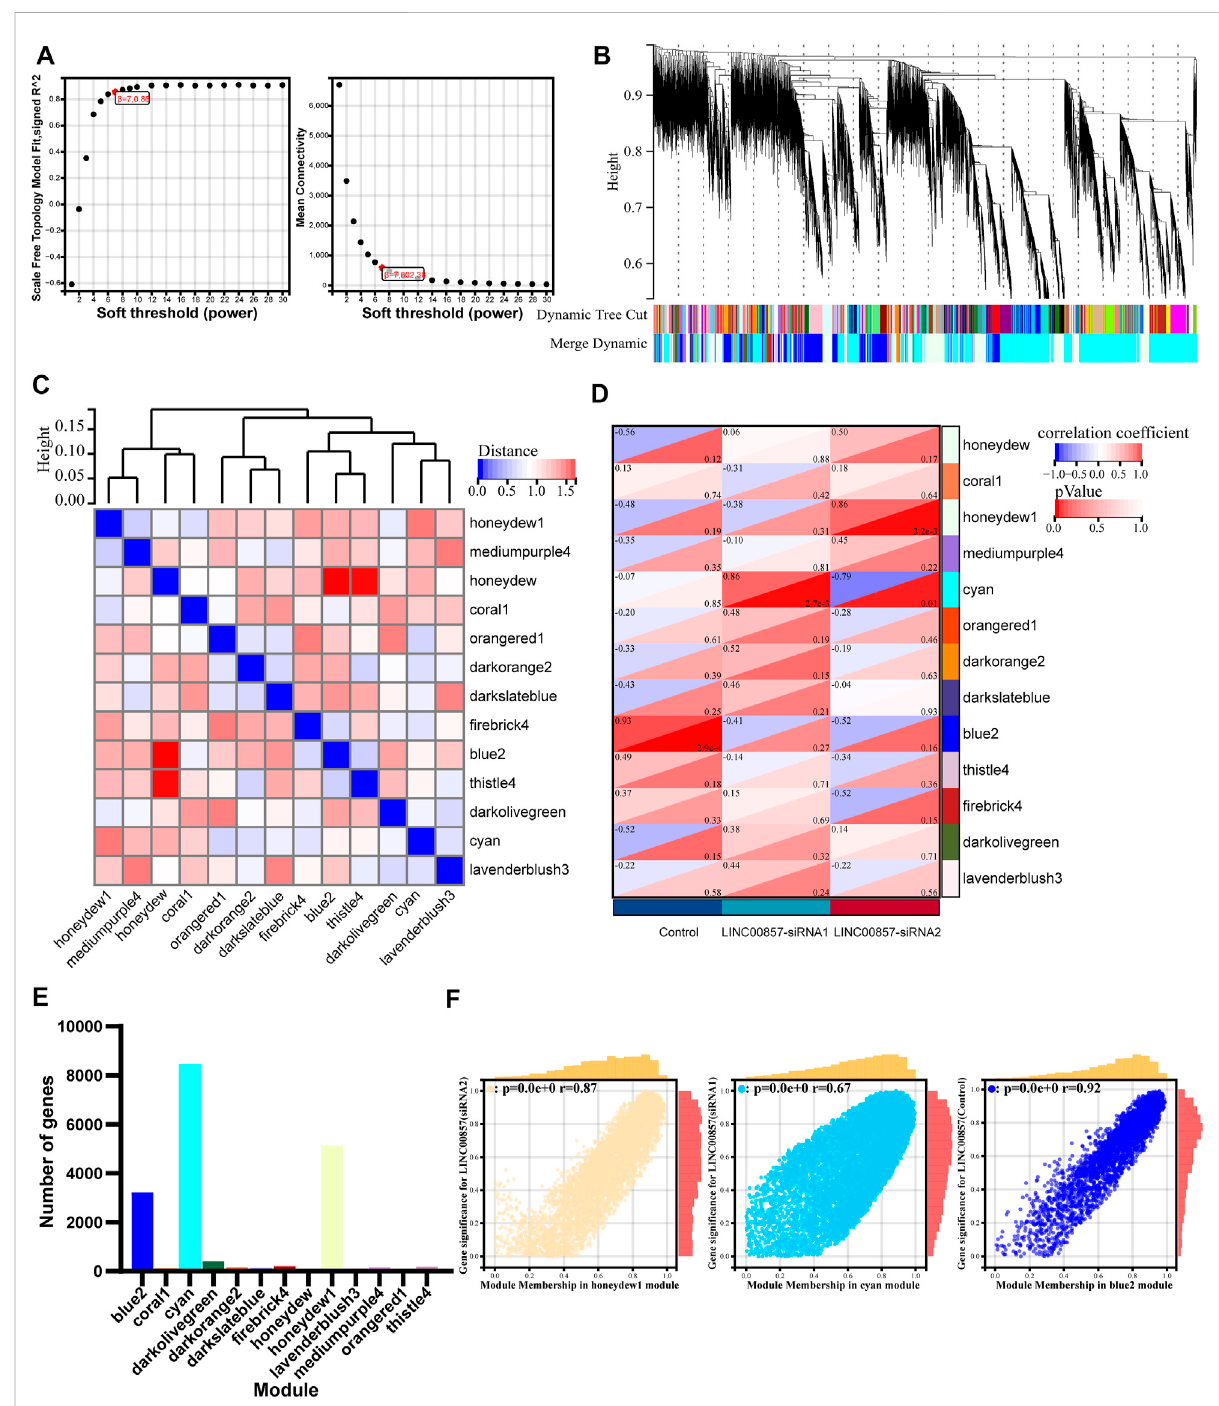
WGCNA after LINC00857 silencing. (A) The soft threshold of the WGCNA module. (B) Cluster dendrogram of LINC00857 RNA-seq expression data and functional modules were created by WGCNA. (C) The interaction between different modules. (D) Heatmap of interrelation between gene modules and sample characteristics. (E) The number of genes per module. (F) Dependence between GS and MM in honeydew 1, cyan and blue 2 modules. P <